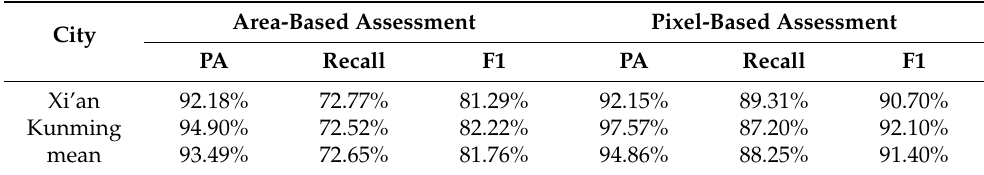
Table 3. Accuracy assessment for Xi’an and Kunming. Area-Based Assessment Pixel-Based Assessment City PA